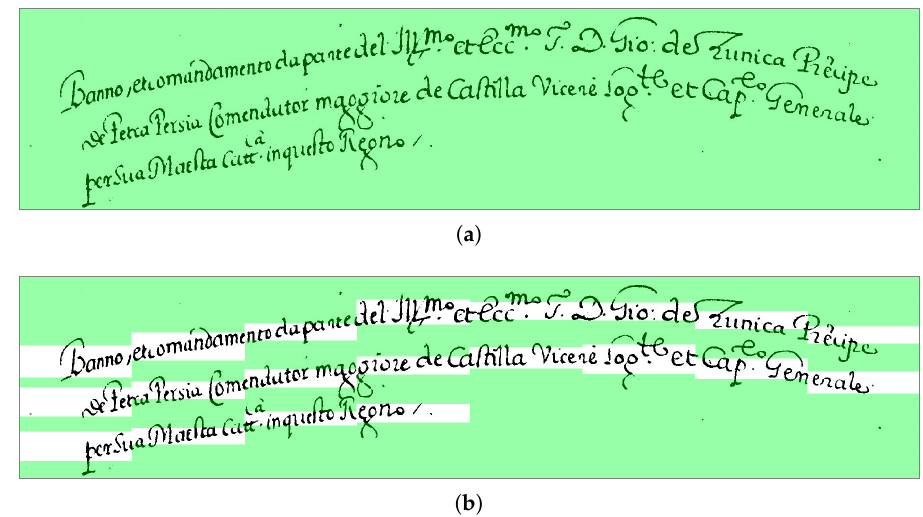
Figure 4. Examples of detection of search areas for text line segmentation: green areas represent the search areas detected by computing the histogram on the whole image ( a ) or on each stripe ( b